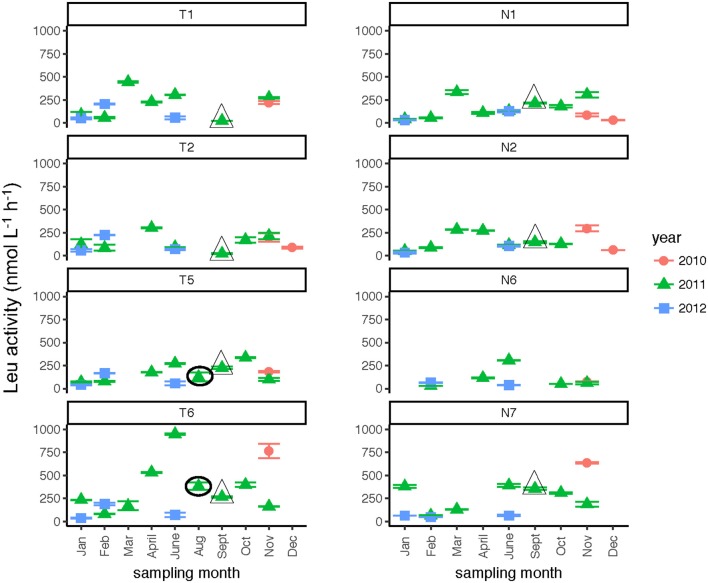
Leu-MCA activities (average and standard deviations) at four stations in the Neuse and Tar-Pamlico Rivers from 2010 to 2012. “T” corresponds to Tar-Pamlico stations, “N” corresponds to Neuse stations. Symbols outlined with triangles show sampling carried out in the month post Hurricane Irene. Circled symbols (Stns. T5 and T6 only) show samples collected in August 2011, shortly after Hurricane Irene crossed through eastern North Carolina.